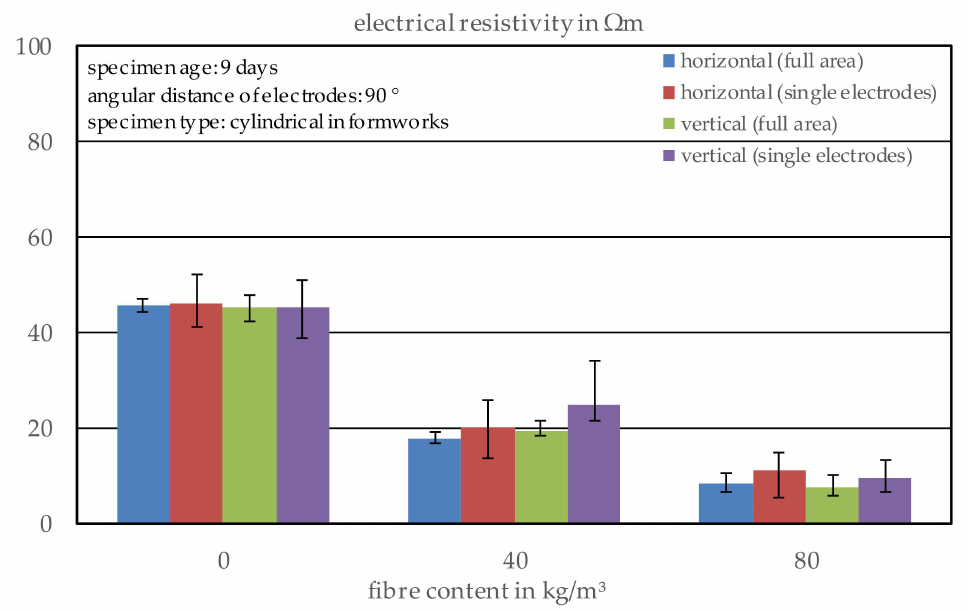
Figure 8. Electrical resistivity in different directions depending on fibre content at a specimen age of 9 days and an electrode array with angular distances of 90 ◦